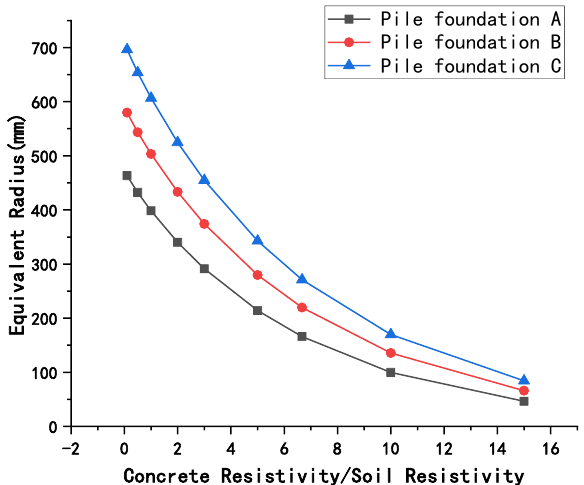
Figure 3. Concrete resistivity/soil resistivity versus the equivalent radius.